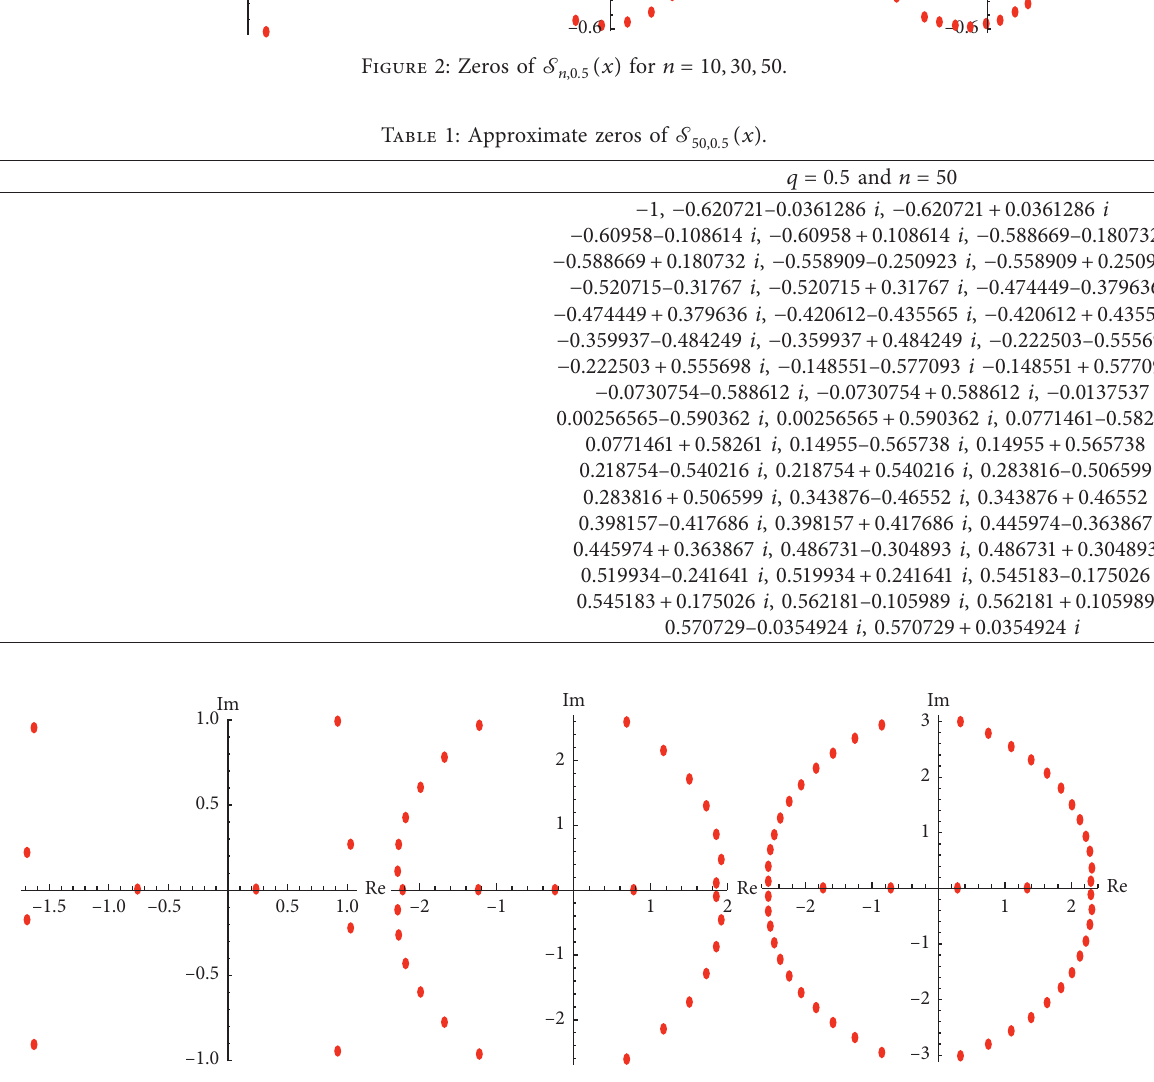
Figure 3: Zeros of S